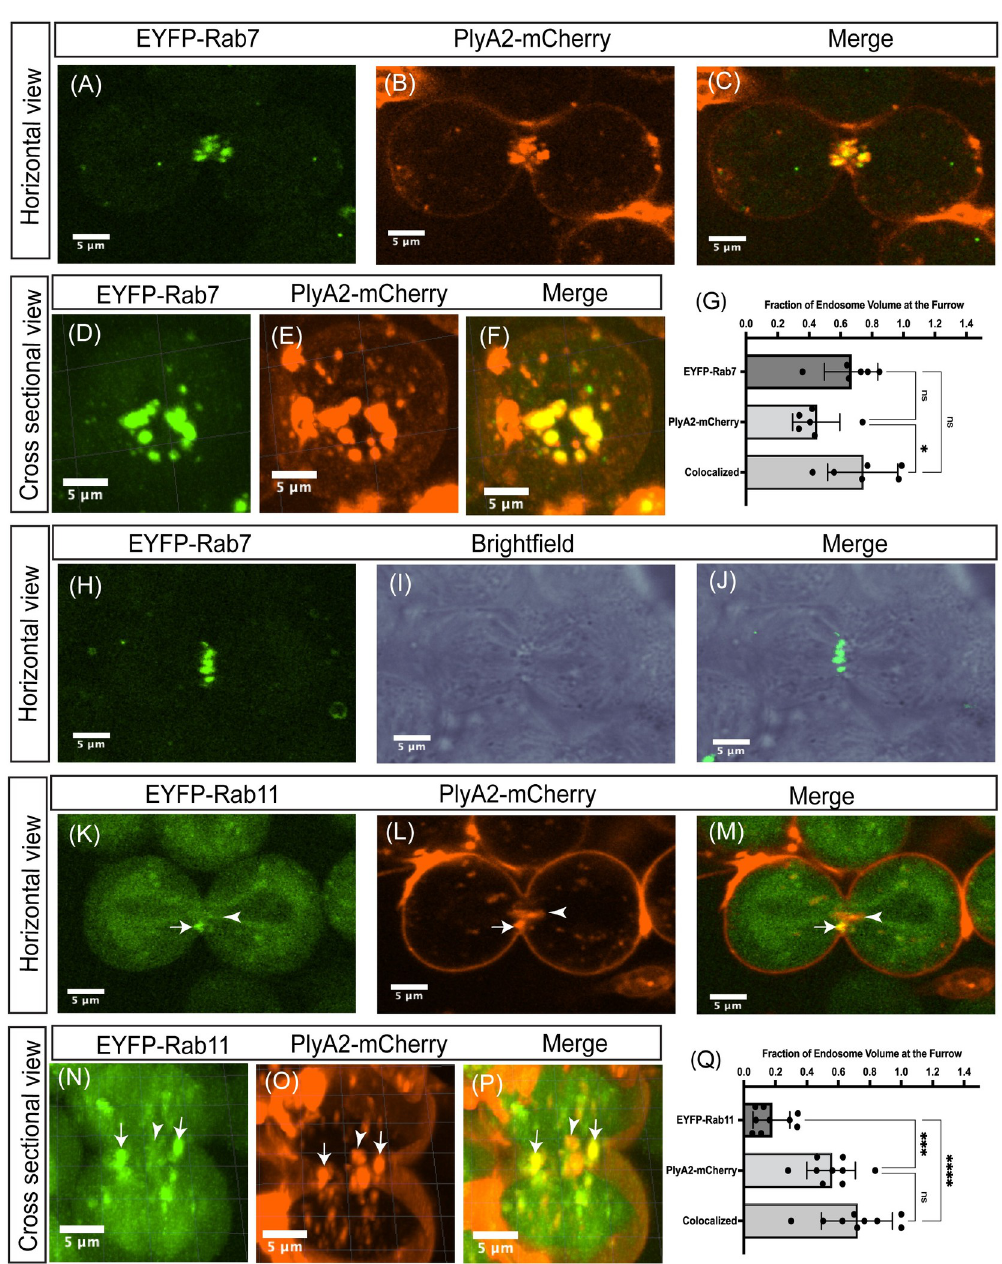
Fig 6. CPE containing endosomes translocate to cleavage furrows during male meiotic cytokinesis. (A–F) The EYFP-Rab7 expressing spermatocytes are treated with PlyA2-mCherry and snapshots of spermatocytes undergoing meiosis I cytokinesis are shown. (A–C) Horizontal view of 1 z slice is shown. (D–F) Cross-sectional view of a spermatocyte undergoing cytokinesis, maximum intensity projection image was shown. (G) Quantification of endosomal volume localized to cleavage furrow in EYFP-Rab7 expressing and PlyA2-mCherry treated spermatocytes. Using surfaces tool in Imaris software, we have calculated the total endosomal volume and fraction of which localized to cleavage furrow in 3D images ( n = 6 spermatocytes from 3 independent experiments). (H–J) Localization of EYFP-Rab7 in intact cysts where spermatocytes are encapsulated by cyst cells. Horizontal view of a single z slice is shown. (K–P) EYFP-Rab11 expressing spermatocytes were treated with PlyA2-mCherry and meiosis I cytokinesis was imaged. (K–M) Horizontal view of single z slice is shown. (N–P) Cross- sectional view, maximum intensity projection image is shown. White arrows indicate colocalization and white arrowheads indicate lack of colocalization. (Q) Quantification of a fraction of endosomal volume localized to cleavage furrow in EYP-Rab11 expressing, PlyA2-mCherry treated spermatocytes. Endosomal volume in 3D images were calculated using surfaces tool in Imaris software ( n = 9 spermatocytes from 3 independent experiments). The data underlying the graphs shown in this figure can be found in S2 Data. CPE, ceramide phosphoethanolamine.